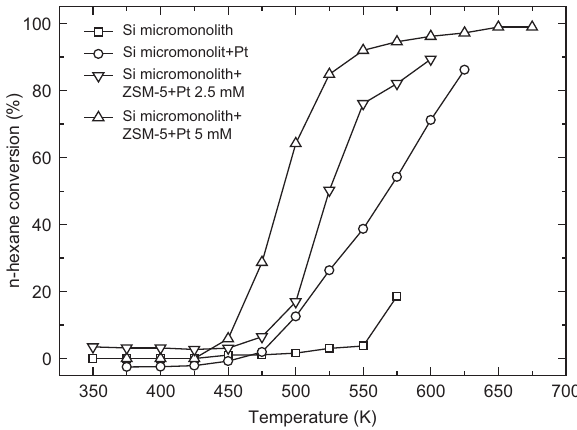
Figure 6 Hexane conversion vs. temperature. Catalytic combus- tion of 200 ppm n-hexane in air. Q = 30